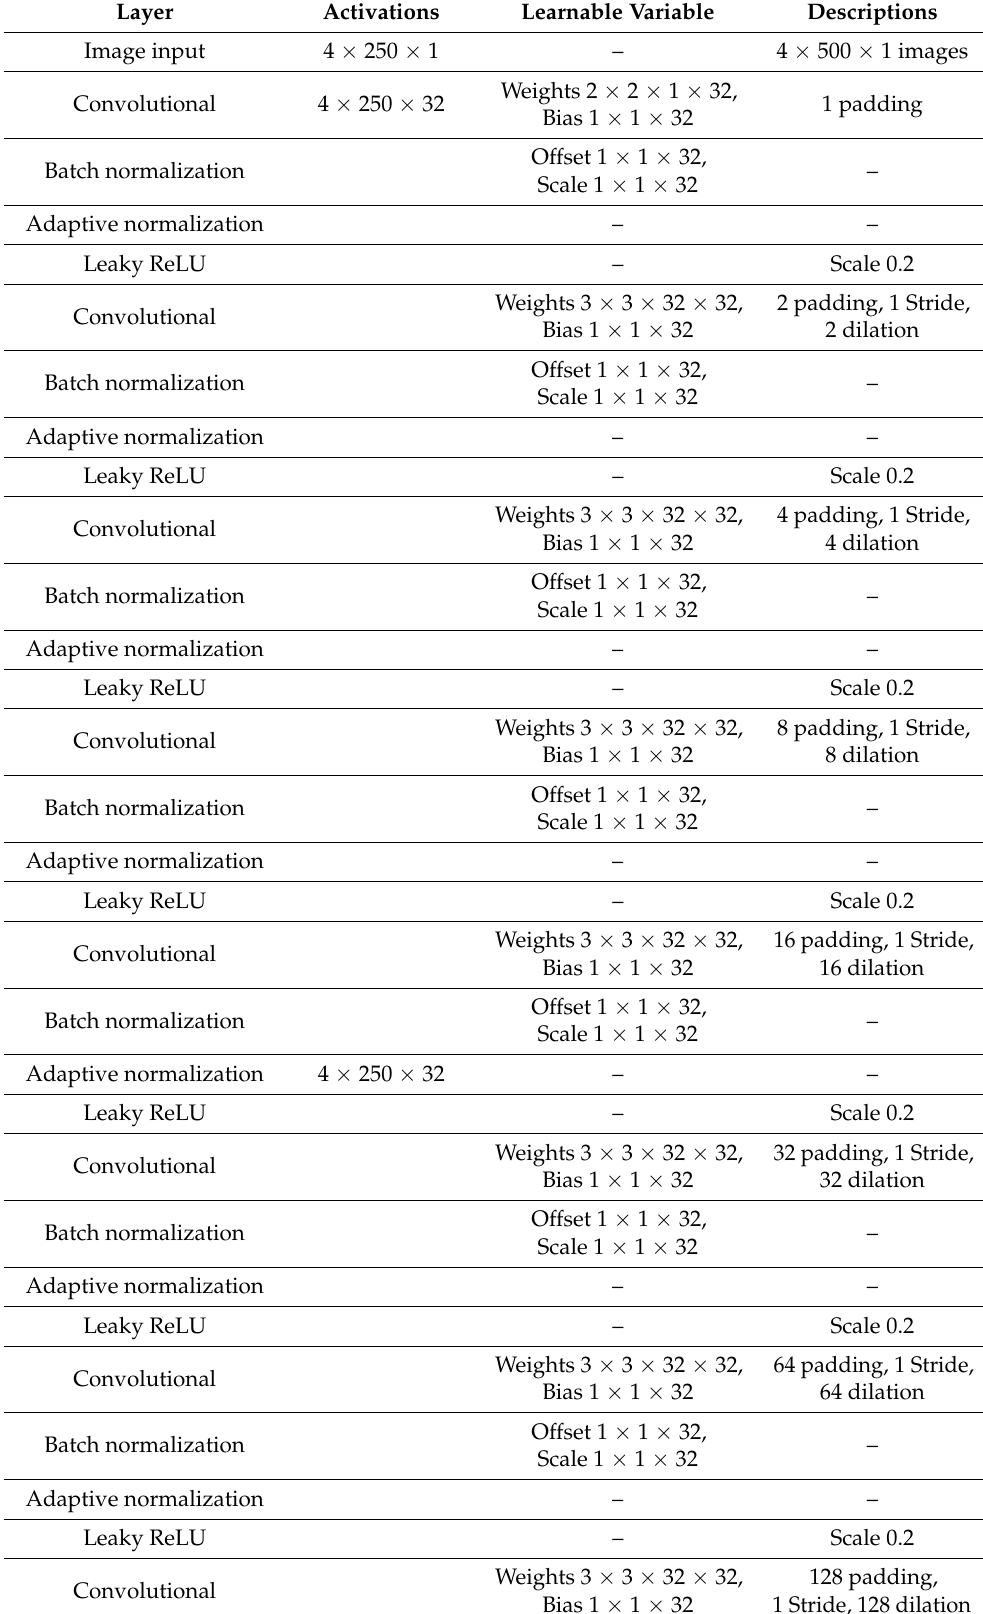
Table 2. Details of the implemented context aggregation